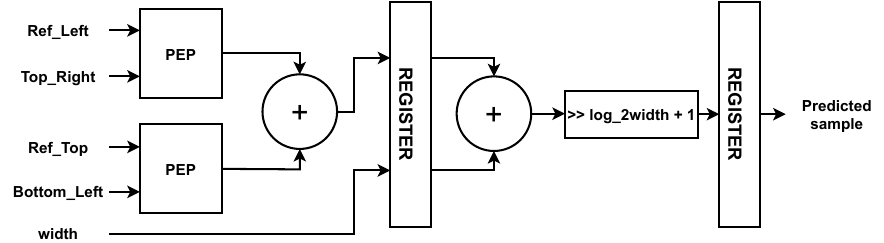
Figure 14. Hardware architecture of Planar sample prediction.